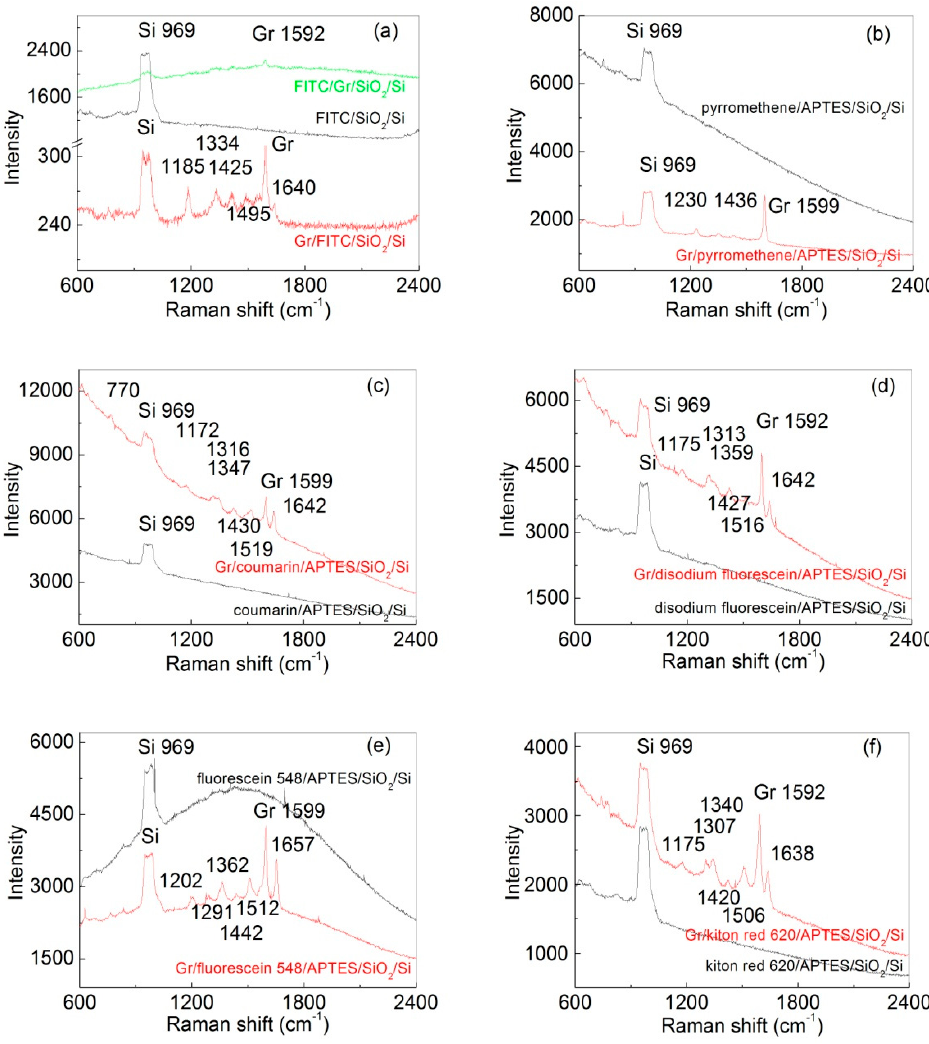
Figure 1. Raman-FL spectra of fluorescein isothiocyanate (FITC) ( a ), pyrromethene ( b ), coumarin ( c ), disodium fluorescein ( d ), fluorescein 548 ( e ), and kiton red 620 ( f ) covered with (red) or without graphene (black). The substrates are SiO 2 /Si in ( a ) and APTES/SiO 2 /Si in ( b – f ). APTES: aminopropyltriethoxysilane. For the green curve in ( a ), the SiO 2 /Si substrate was first covered with a single layer graphene forming a Gr/SiO 2 /Si structure (Gr: graphene), then the FITC dyes were adsorbed above graphene. The Raman integration time was 30 s (red and green spectra in ( a )), 10 min (black spectrum in ( a )), or 20 min (for ( b – f )). The peaks at 969 cm − 1 and ca. 1590–1599 cm − 1 were from Si and graphene, respectively.